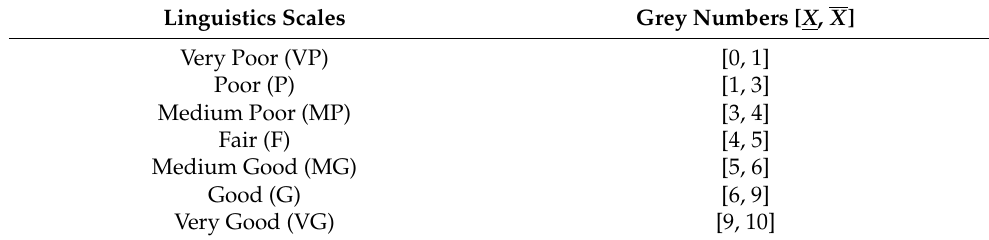
Table 2. The linguistics scales used in